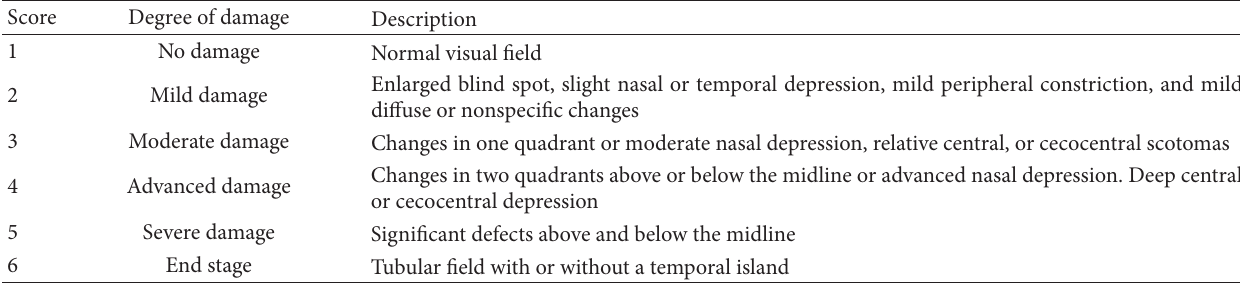
T 1: Visual �eld scoring